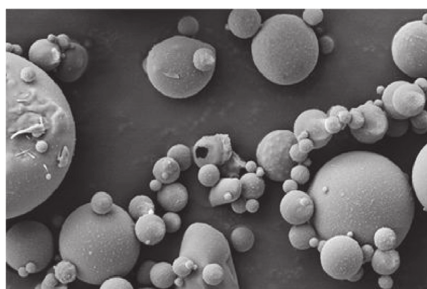
Figure 3: SEM image of fly ash.